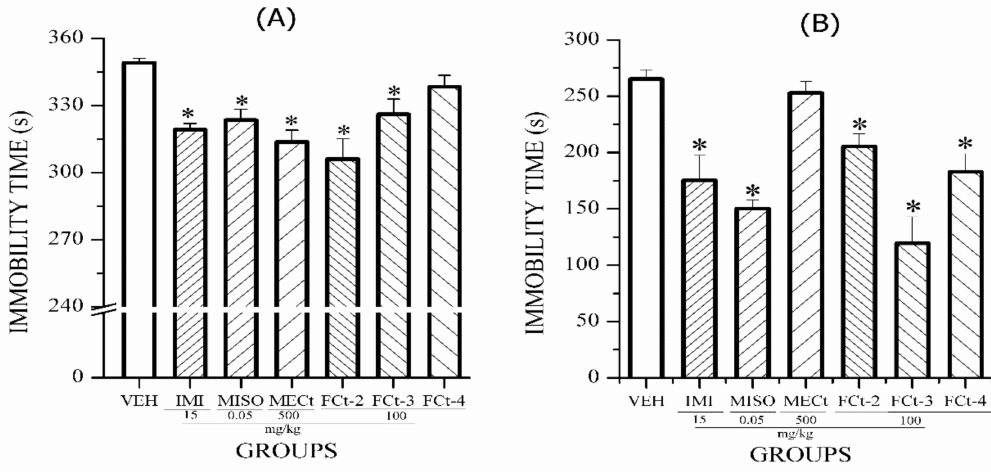
Figure 5. Effect of oral administration of MECt, FCt-2, FCt-3 and FCt-4 on immobility time of ICR mice during the tail suspension test (TST; ( A )) and forced swim test (FST; ( B )). ANOVA followed by post hoc Bonferroni test (mean ± SEM) * p ≤ 0.05, compared to the VEH control